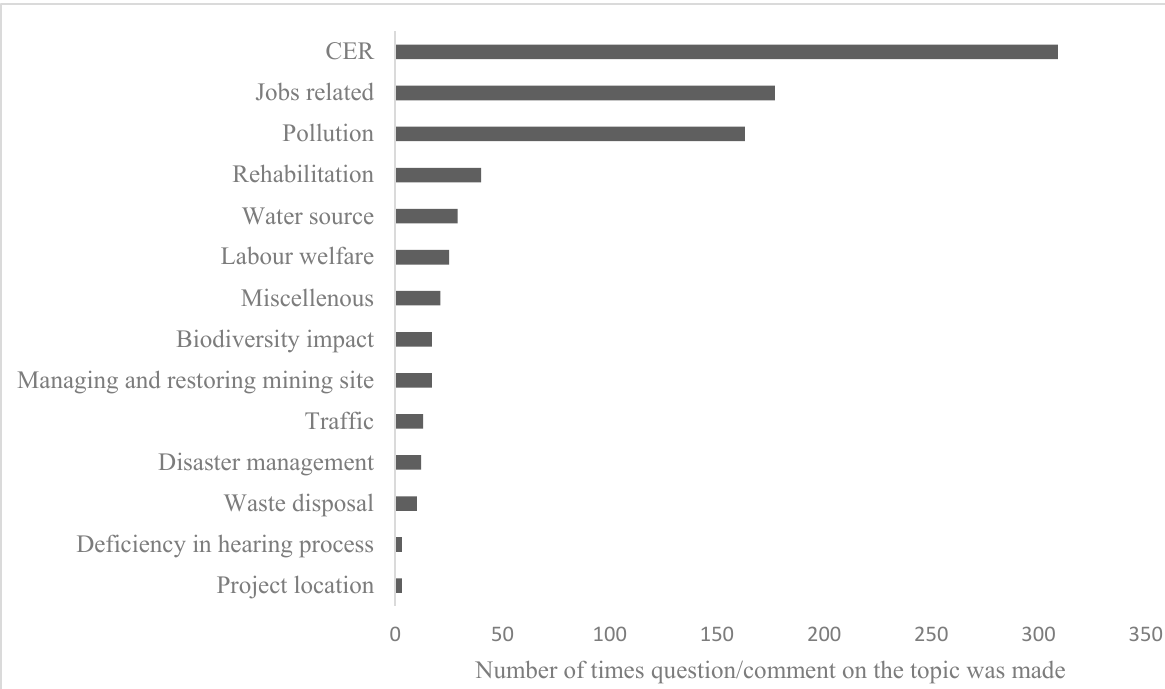
Figure 1. Number of persons speaking up in the 50 public hearings corresponding to 50 different proposed projects.